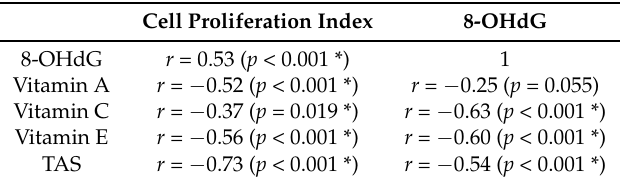
Table 5. Interrelationship between cell proliferation activity and oxidative stress markers. Cell Proliferation Index